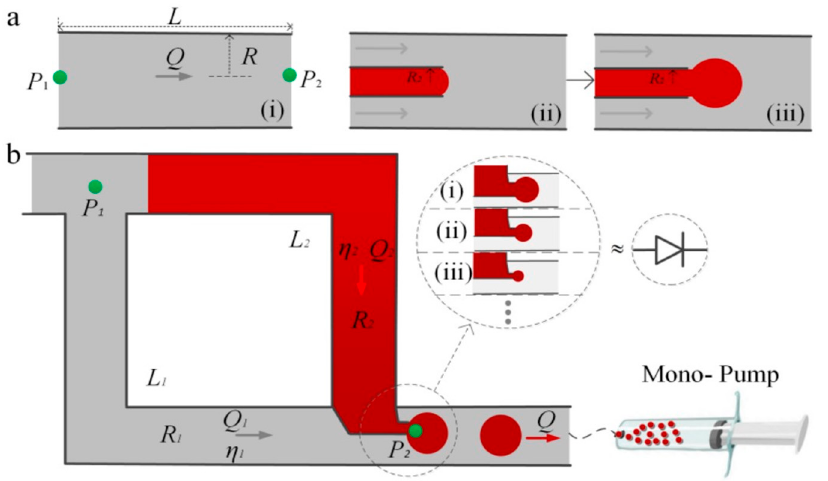
Figure 1. Schematic of the droplet generator. ( a ) Dynamic process of the droplet generator, ( i ) dimensional relationship in principles of Poiseuille law, ( ii ) water phase reached fluid tangent position, ( iii ) forming a droplet under the action of fluid shear force. ( b ) Schematic of droplet generator.